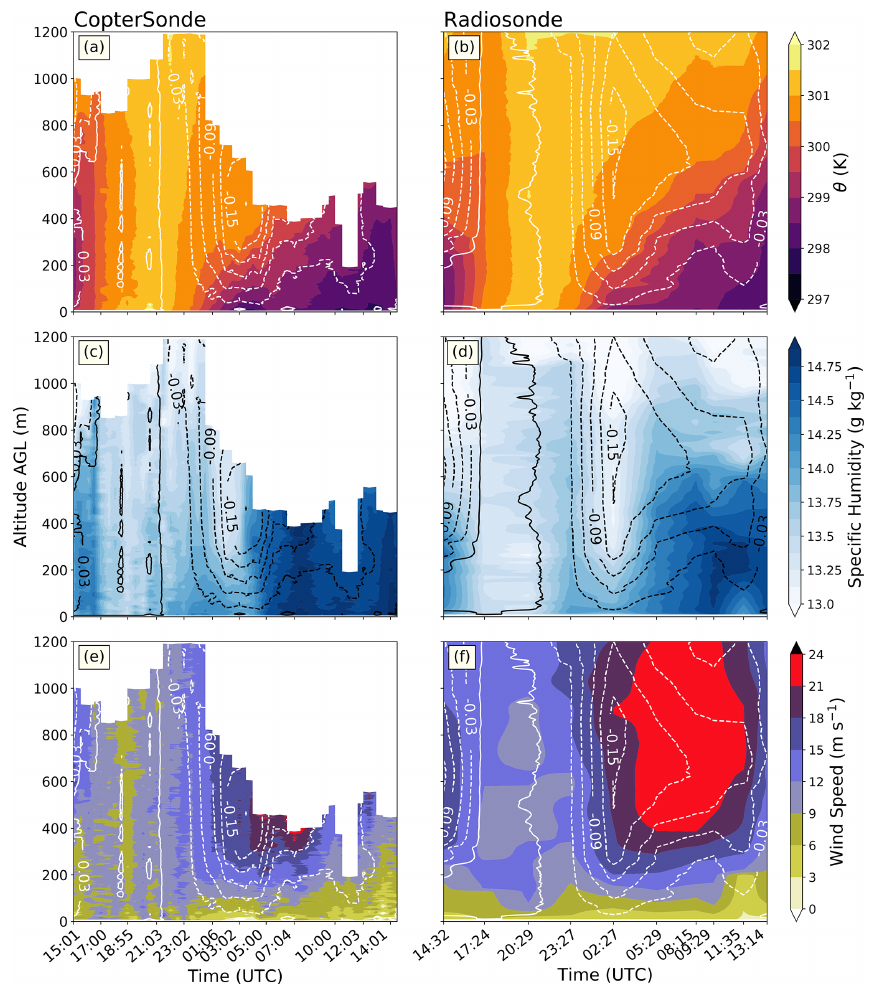
Figure 3. Shaded contour fields on 5–6 October 2018 of (a, b) potential temperature (K), (c, d) specific humidity (gkg − 1 ), and (e, f) wind speed (ms − 1 ), with the buoyancy contours overlain (ms − 2 ) at KAEFS. Dashed (solid) contours are negative (positive). Panels (a) , (c) , and (e) use CopterSonde data, and panels (b) , (d) , (f) use radiosonde